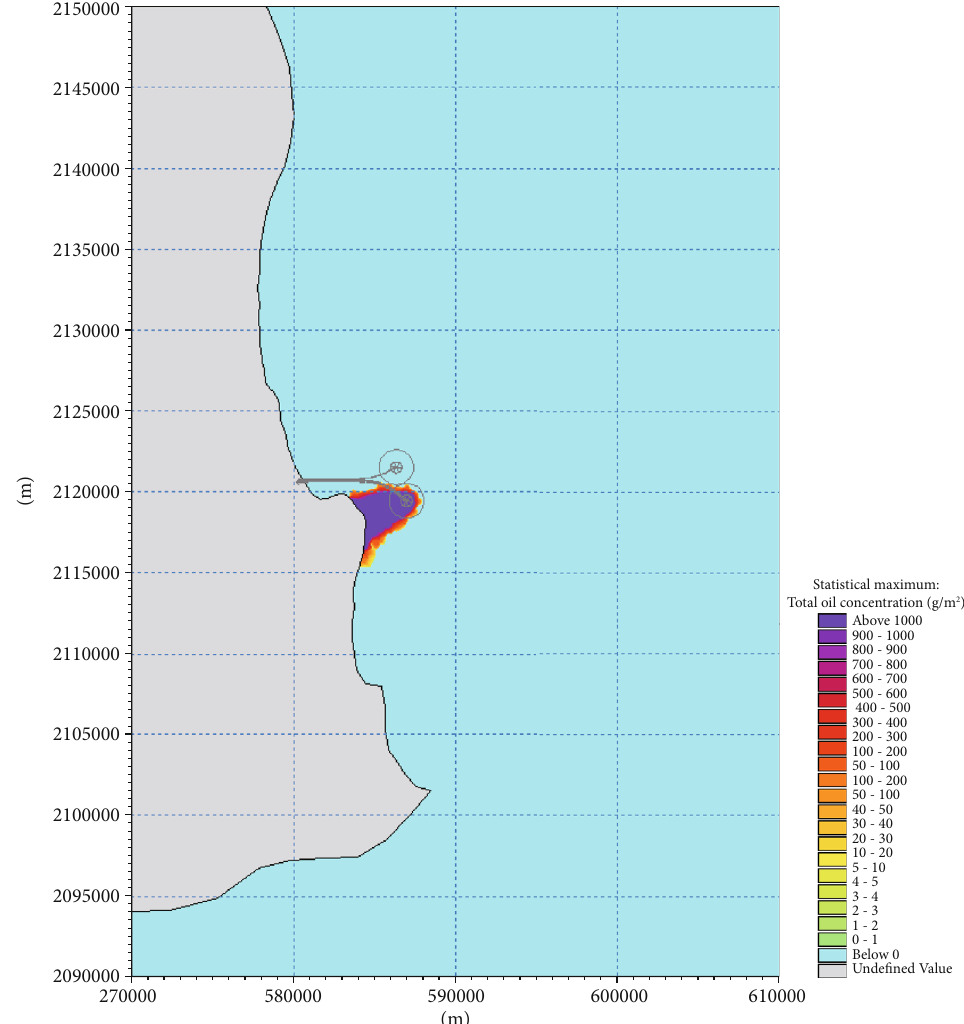
Figure 13: Map of maximum oil concentration for scenario 1 (subsurface blowout: 16,000 m 3 spill at SPM1) (under typical wind in the winter